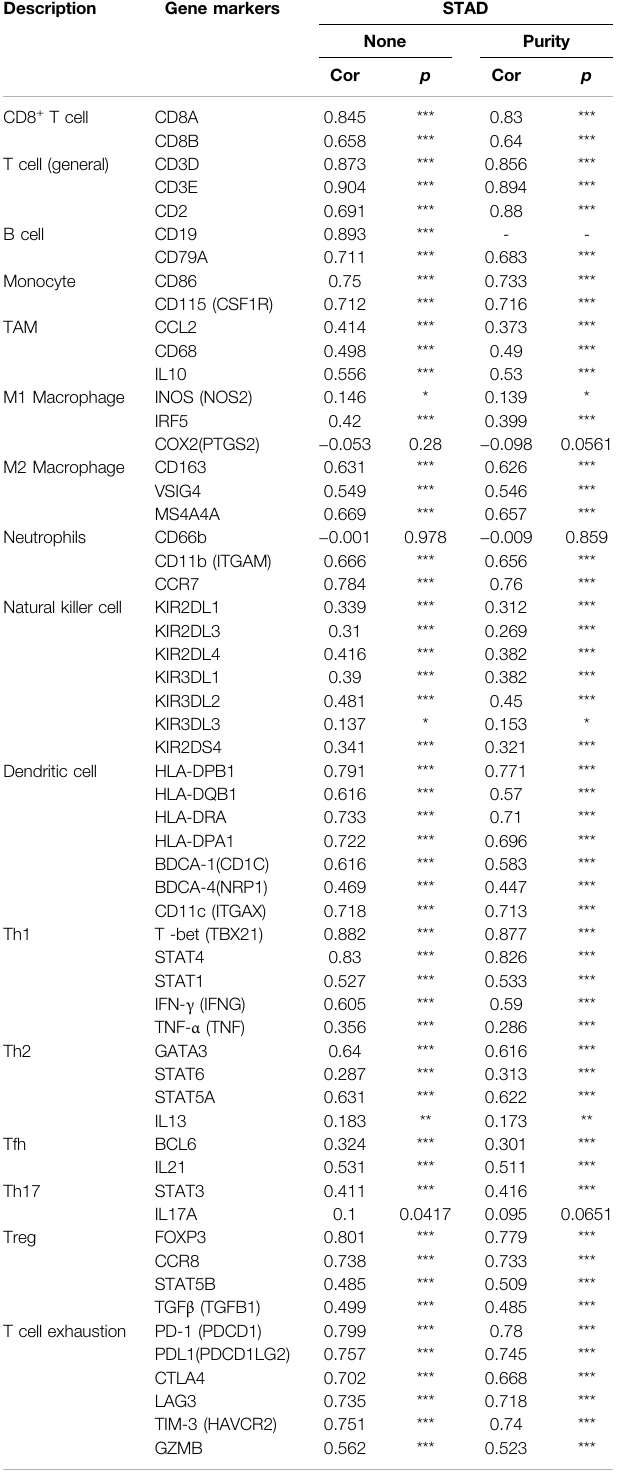
TABLE 2 | Correlation analysis between ITGAL and related genes and markers of immune cells in Tumor Immune Estimation Resource (TIMER2.0). Description Gene